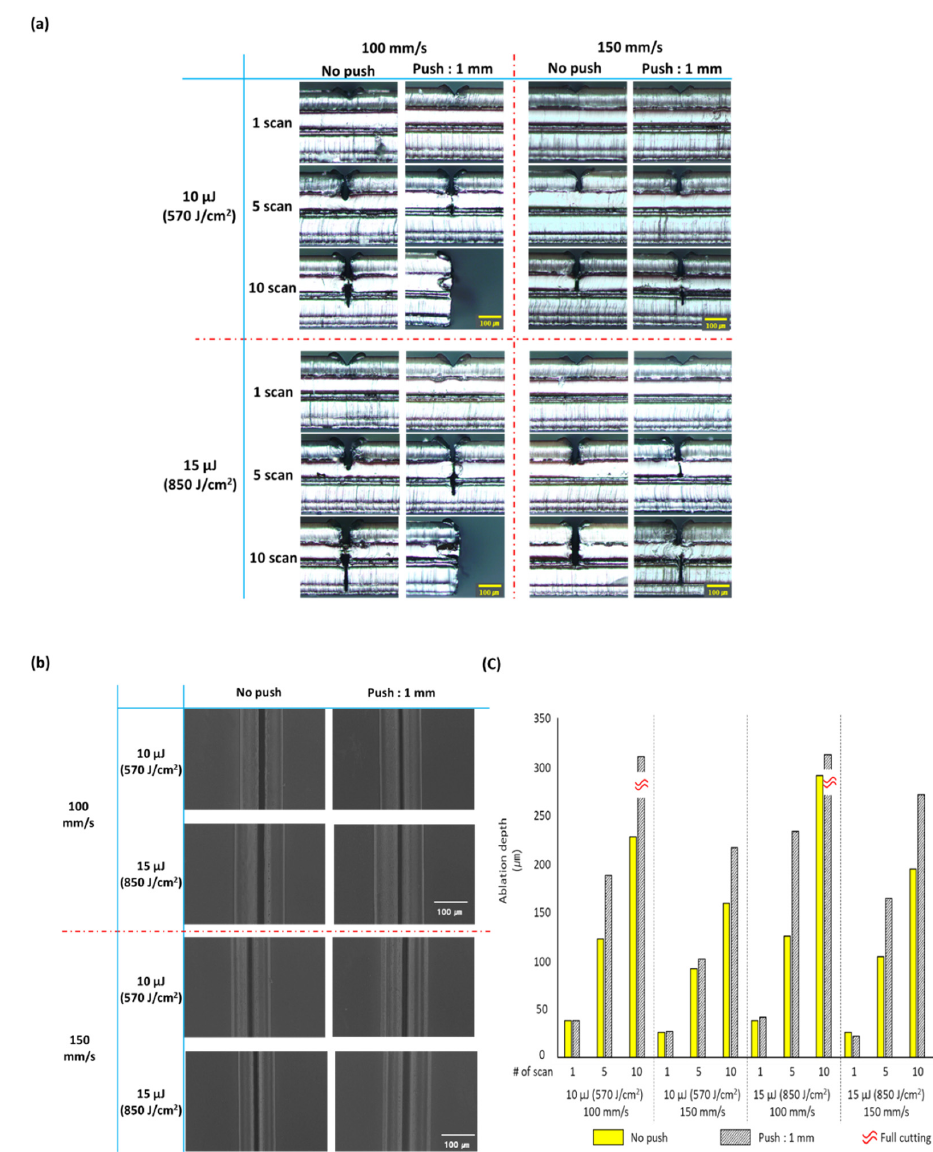
Figure 2. Processing result of the fine curvature on the sample generated in the preliminary preparation in an optical system based on an objective lens in comparison with the conventional laser ablation result: ( a ) cross-section measurement result using an optical microscope, ( b ) comparison of the sample surface condition by FE-SEM between the conventional laser ablation and the processing by the preliminary preparation after five scans, ( c ) measurements of ablation depth through the conventional laser ablation and the processing by the preliminary preparation under various